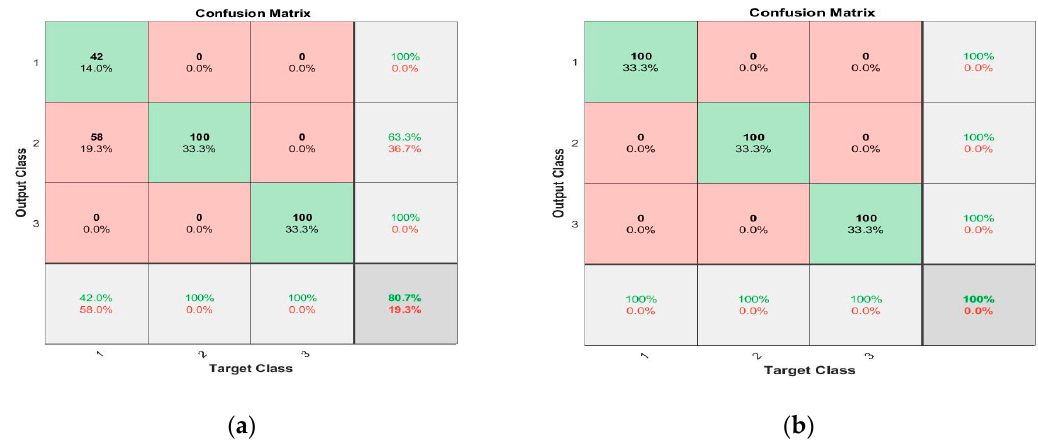
Figure 14. ANN confusion matrix (trained at 1800 rpm, 3 Nm load; tested at 600 rpm, 0 Nm load): ( a ) all features; ( b ) robust features.